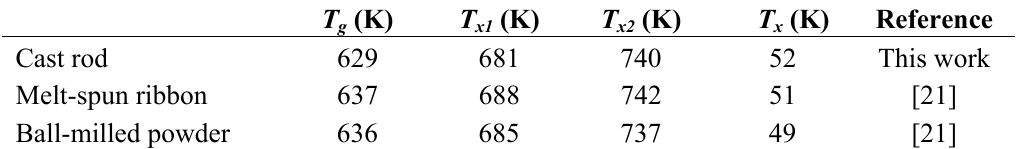
Table 1. Temperature of the glass transition ( T ( T ) crystallization peak and extension of the supercooled liquid region (  T x2